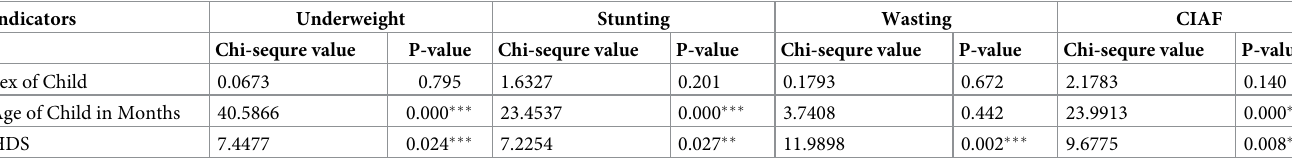
characteristics. Srinivasan and Mohanty [2] revealed a high influence of household deprivation on preschool children’s nutritional status [2, 13]. The results reveal that malnutrition in the Rahimyar Khan District is relatively higher in comparison with the overall national level (S2 Table). The findings depict that the unavailability of some basic amenities of life at the household level significantly affects the nutritional status of pre-school children. The prevalence of under- weight, stunting, and wasting for three groups of household deprivation in Rahimyar Khan as displayed in Fig 3A suggests that the expected tendency of malnutrition is worst for categories of HDS-1 and HDS-2 household socioeconomic deprivation. The study finds that as house- hold shifts from HDS-1 to HDS-2 and then to HDS-3 prevalence rates of stunting and under- weight decrease. This is probably due to the improvement in basic amenities of life that takes place. Nonetheless, no substantial impact on the wasting was observed owing to change in the household’s socioeconomic status. The main problem of malnutrition in the district is stunting and underweight as the rates of stunting and underweight are higher compared to the rate of wasting. Similarly, evidence was also shown by previous national and provincial surveys in Table 5. Association between anthropometric indicators with sex of child, age of child and HDS.